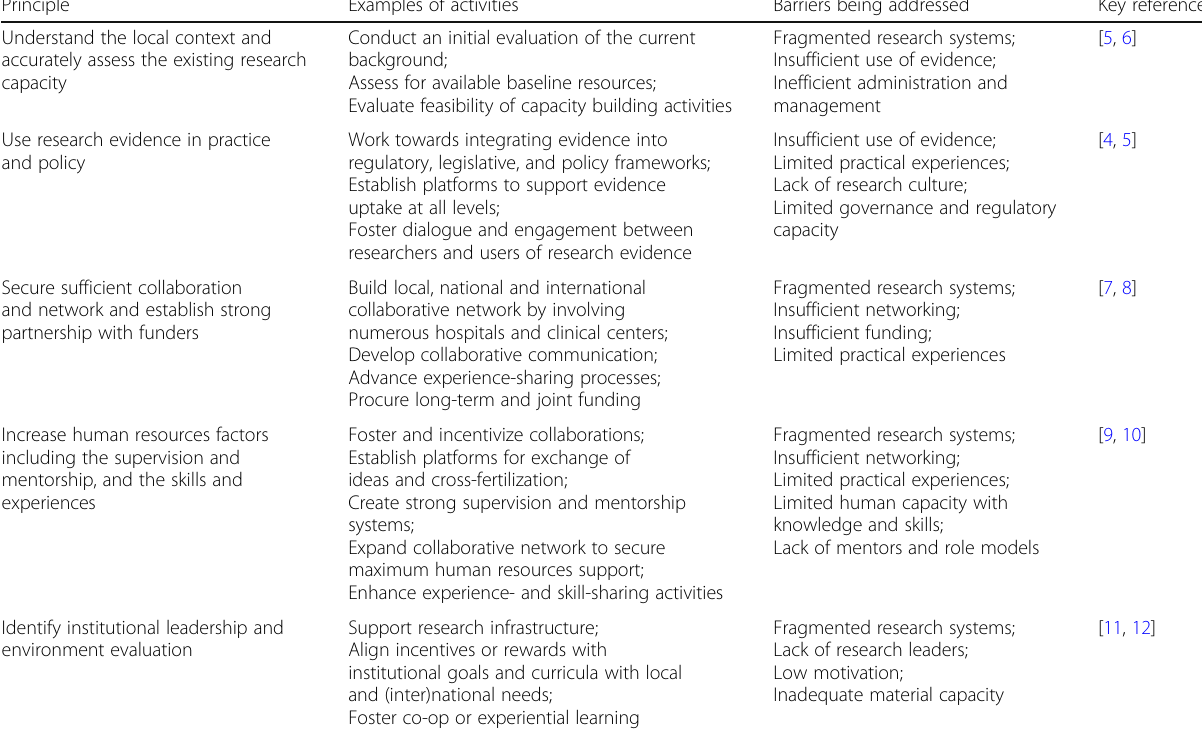
Table 1 Insights on how to overcome the key barriers in building research network capacity